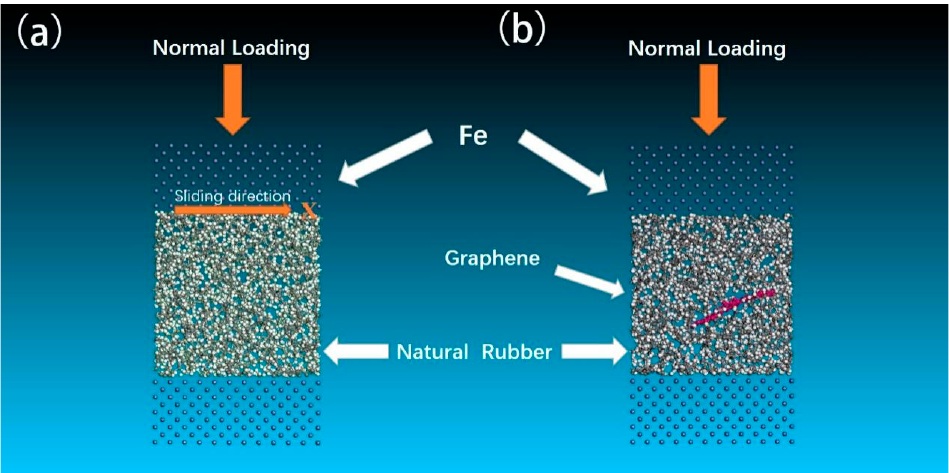
Figure 6. Molecular friction pair configuration: ( a ) pure natural rubber and iron layer model; ( b ) graphene/natural rubber and iron layer model.